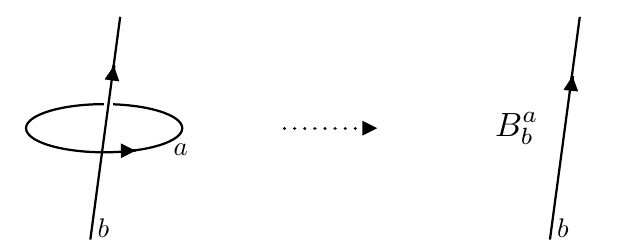
Figure 3 . Fusion of lines L a and L b